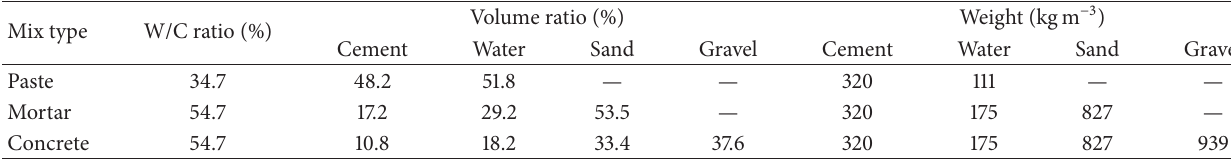
Table 3: Mix proportions for paste, mortar, and